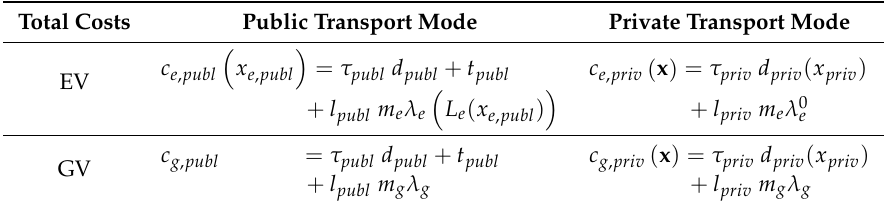
Table 1. The total costs for EV and GV in different transport